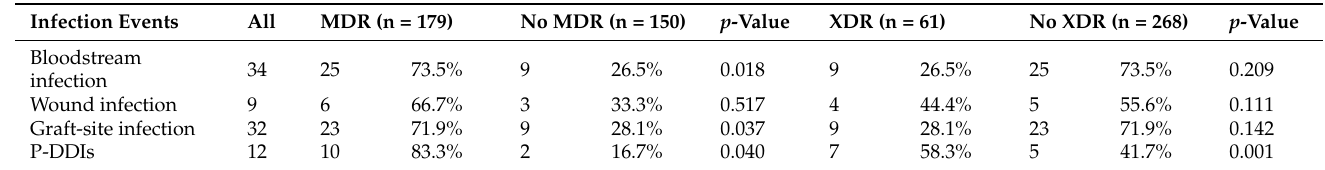
Table 4. Impact of antimicrobial resistance of pathogens on early infection-related events after kidney